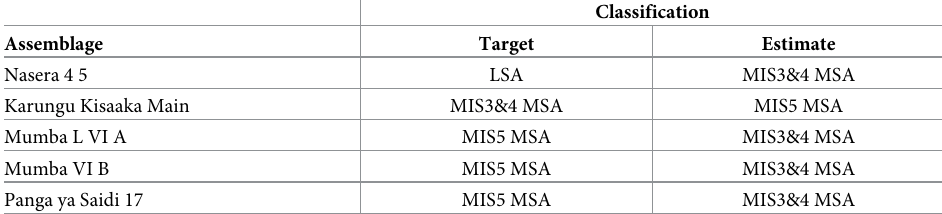
Table 2. Assemblages misclassified in the 3-way